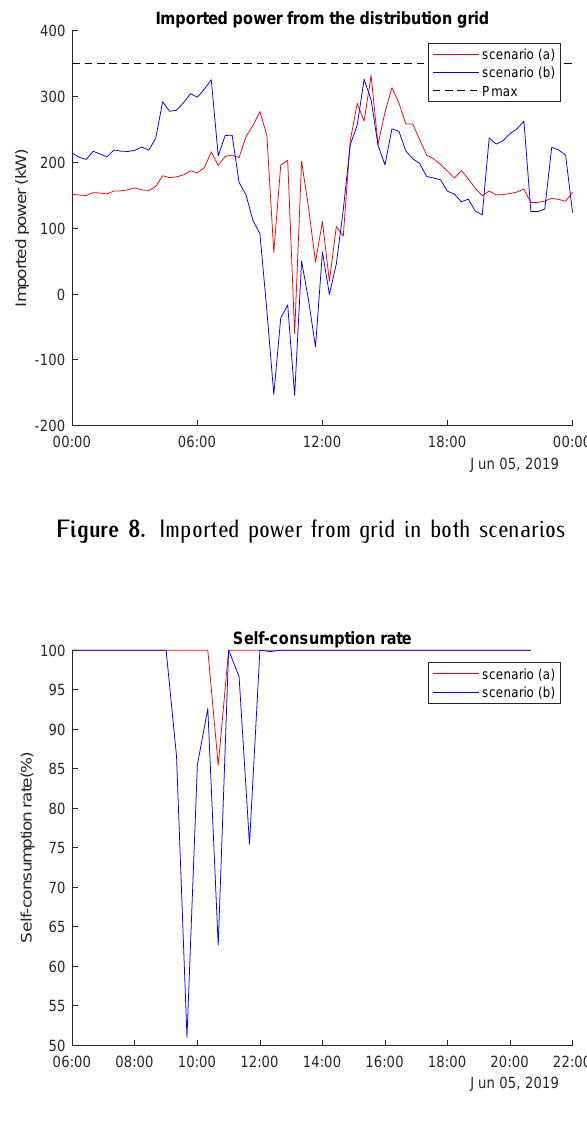
Figure 9. Self-consumption rate for scenarios (a) and